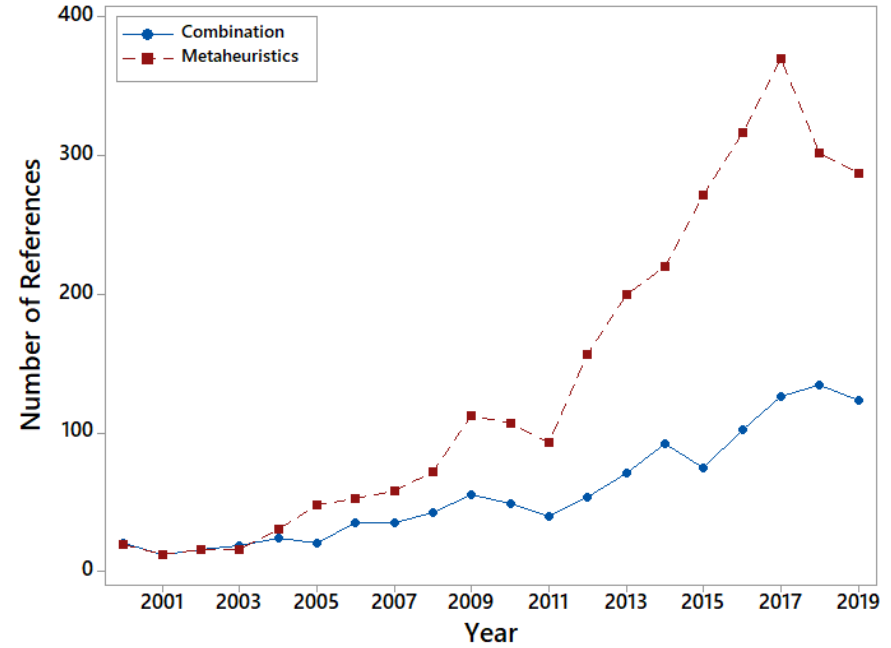
Figure 2. Time evolution of Metaheuristics and Simulation references in Business and Management in the Web of Science.